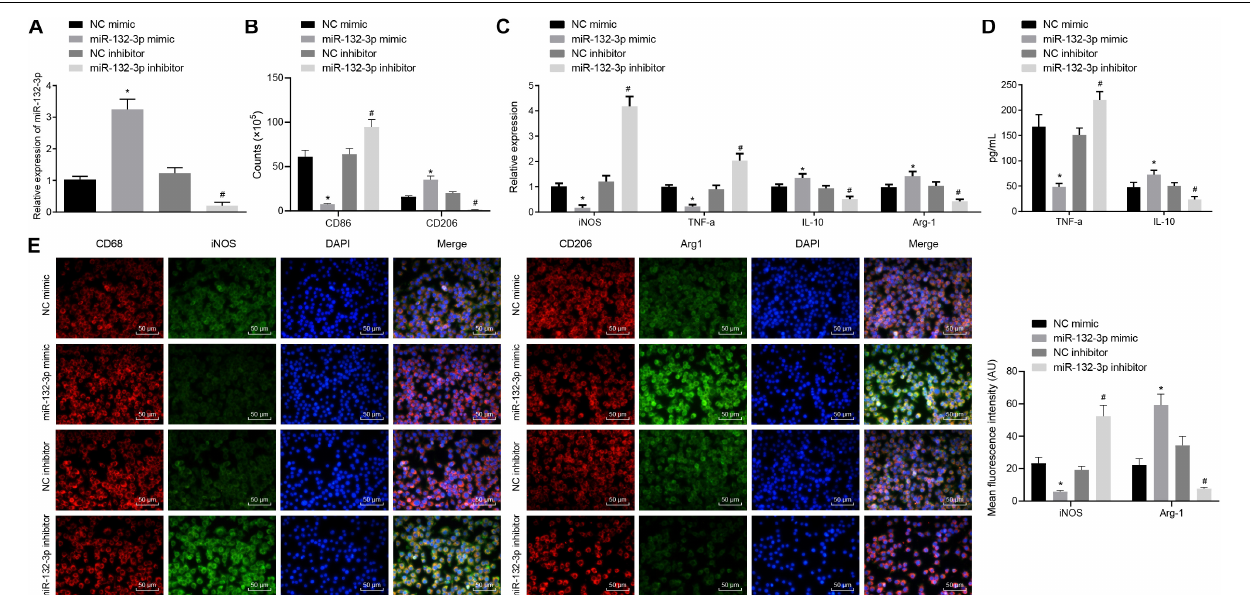
FIGURE 2 | miR-132-3p inhibits M1 polarization of macrophages from SCIR injury rats. The macrophages from SCIR injury rats were transfected with miR-132-3p mimic, miR-132-3p inhibitor, or their corresponding NC plasmids. (A) Expression of miR-132-3p in macrophages detected by RT-qPCR. (B) Expression of CD86 (a specific markers of M1 phenotype) and CD206 (a specific marker of M2 phenotype) in macrophages detected by flow cytometry. (C) Expression of iNOS, TNF- α , IL-10, and Arg-1 in macrophages measured by RT-qPCR. (D) Contents of TNF- α and IL-10 in macrophages determined by ELISA. (E) Expression of iNOS and Arg-1 in macrophages measured by immunofluorescence staining. * p < 0.05 vs. macrophages transfected with NC mimic. # p < 0.05 vs. macrophages transfected with NC inhibitor. Measurement data were expressed as mean ± standard deviation. Differences between two groups were compared by unpaired t -test and those among multiple groups were compared by one-way ANOVA. The experiment was repeated three times